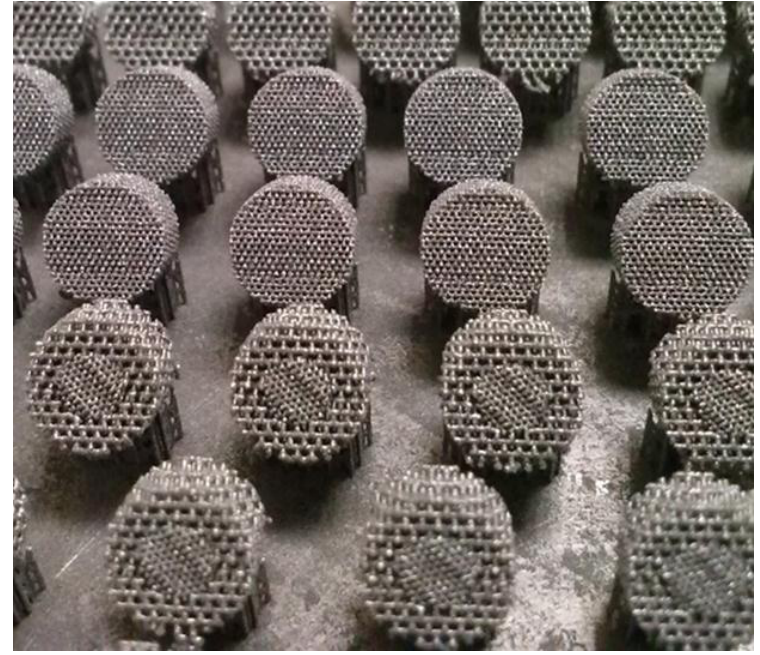
Figure 2. Series of titanium scaffolds with different pore sizes fabricated in one working batch. Table 1. The process parameters used for scaffolds fabrication.